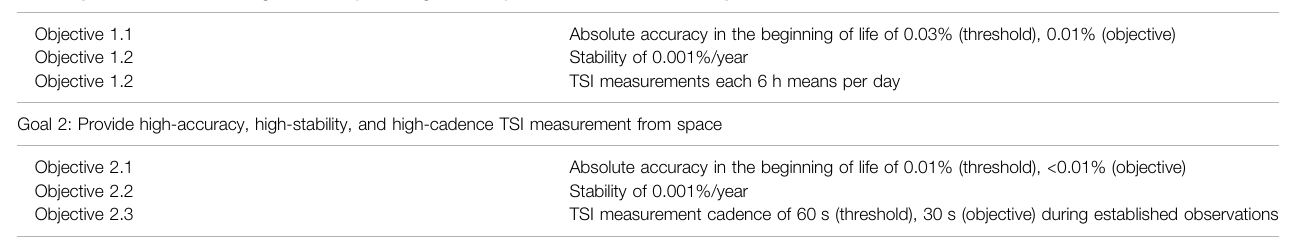
TABLE 2 | Mission goals and objectives. Goal 1: provide continuous high-accuracy and high-stability TSI measurement from space Objective 1.1